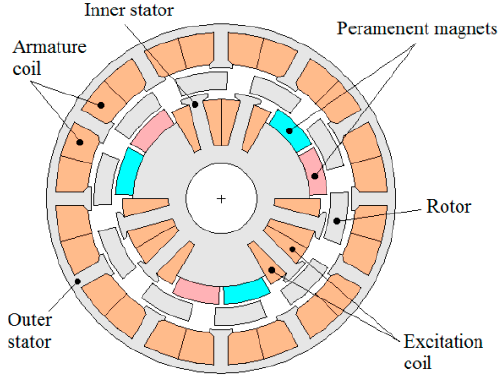
Figure 4. Separate stators hybrid excitation machine.